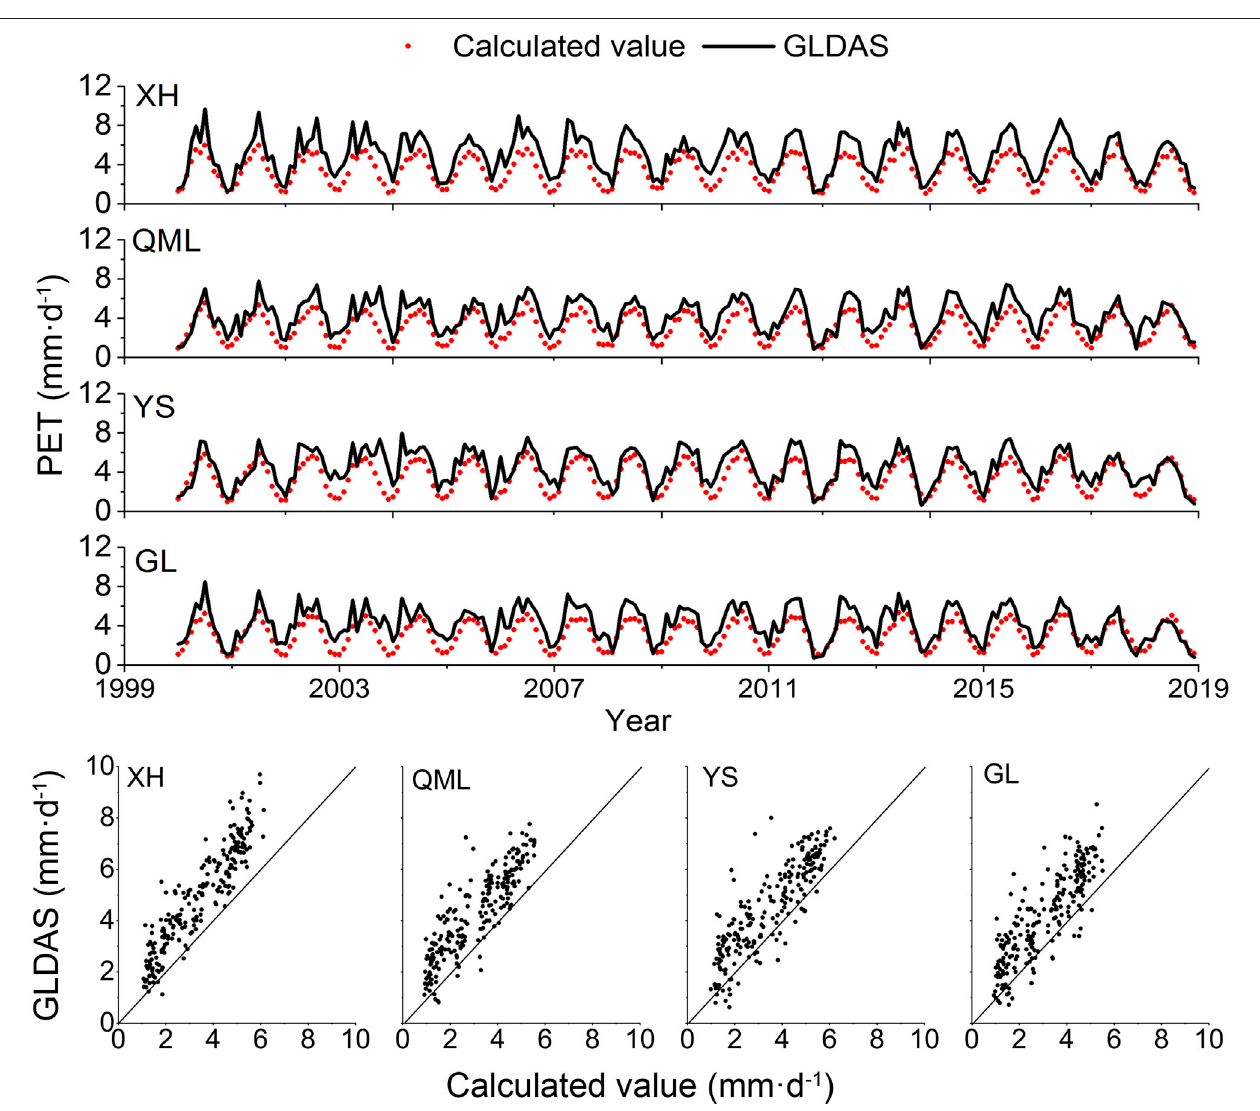
FIGURE4 | Comparison ofcalculated dailyaveragePET and Global Land Data Assimilation System (GLDAS) simulations from four weather stations in TRHregion during 2000 – 2018.